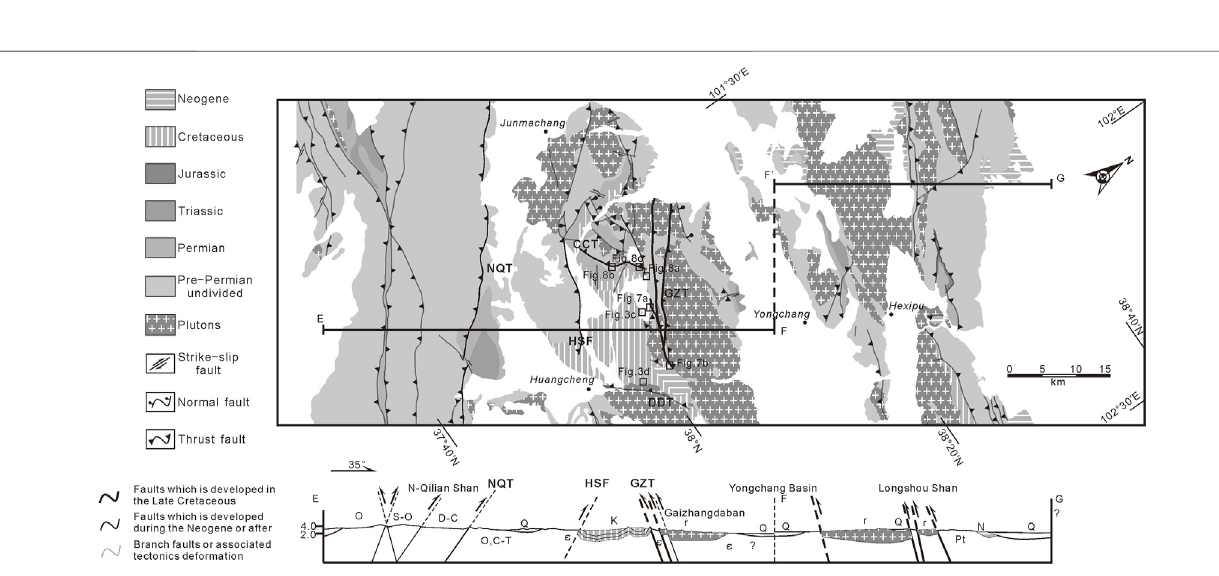
Frontiers in Earth Science |